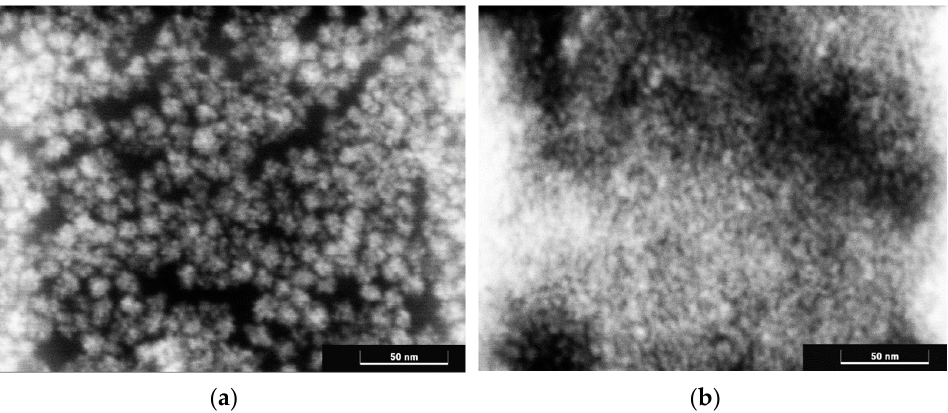
Figure 4. Micrographs of cerium dioxide sols stabilized with ( a ) 2-ethylhexanoic acid and ( b ) octanoic acids obtained by scanning transmission electron microscopy.